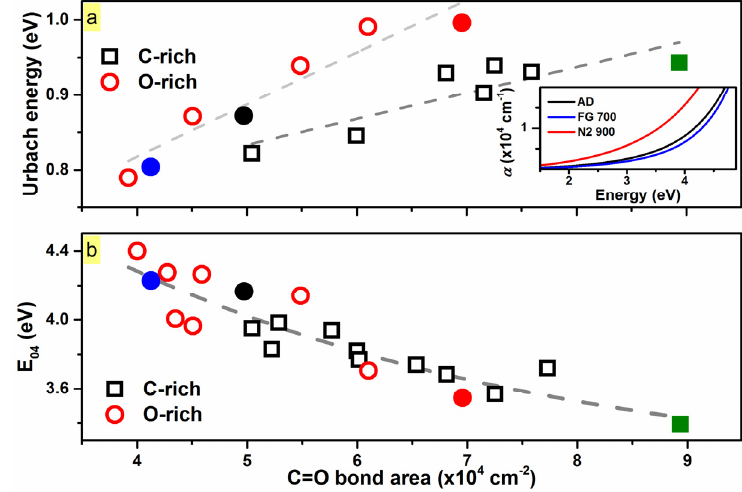
Figure 3. ( a ) Urbach energy ( E u ) of both compositions of SiC x O y related to the carbonyl bond area from the infrared absorption spectra. E u was determined based on the following equation, α = α 0 e ( where α is the absorption coefficient, α 0 is a constant, and E u is the Urbach energy. E u energies are correlated linearly and trend upward with increasing carbonyl (gray dashed lines), suggesting increasing band tail width with increasing carbonyl. Inset: The absorption coefficient ( α ) as a function of energy for the O-rich as-deposited, FG 700 °C, and N 2 900 °C passivated samples. Increased sub- gap absorption was seen in the case of the 900 °C N 2 -annealed SiC x O y thin film; ( b ) E 04 of both compositions of SiC x O y related to the carbonyl bond area. The E 04 values decrease with increasing carbonyl present in the films. Gray dashed line is a guide-to-eye.